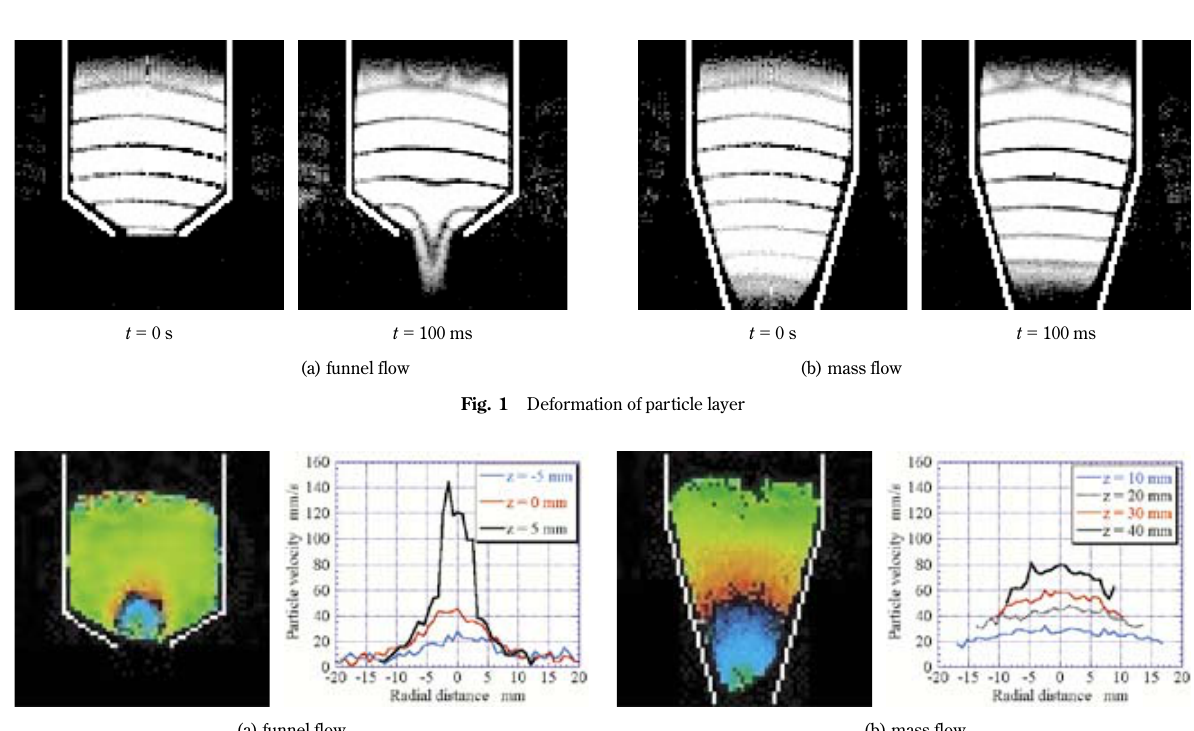
Fig. 2 Distribution of particle